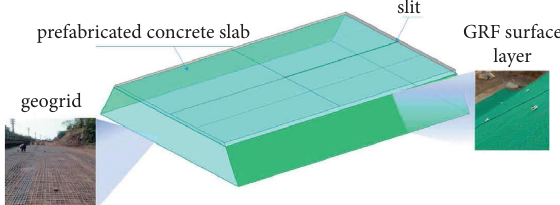
Figure 1: Schematic diagram of a fexible prefabricated highway